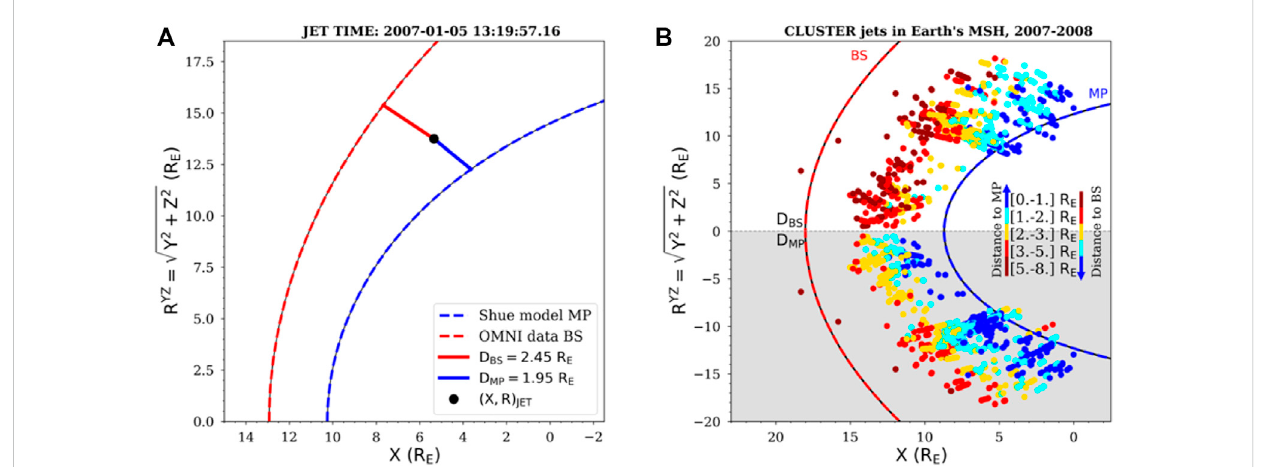
FIGURE 3 (A) Example of the estimated distance from the jet to the magnetopause (blue-curve) and to the bow shock (red-curve), (B) Overview of all jets locations in the ( X , R YZ ) GSE plane: Positive R plane shows distances with respect to the bow shock; negative R plane (gray shaded area) shows distances with respect to the magnetopause. The blue and red curves indicate the innermost magnetopause and the outermost bow shock within the entire set.